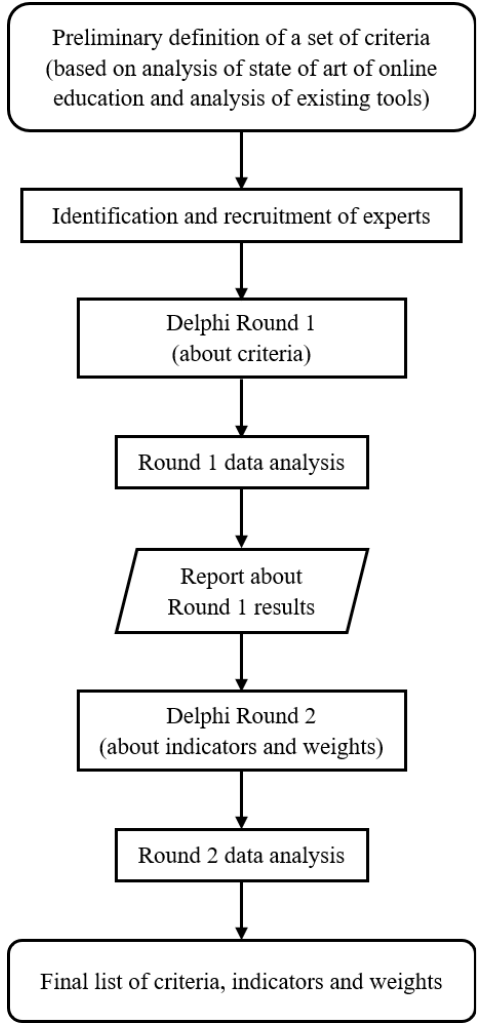
Figure 1 . Delphi study research